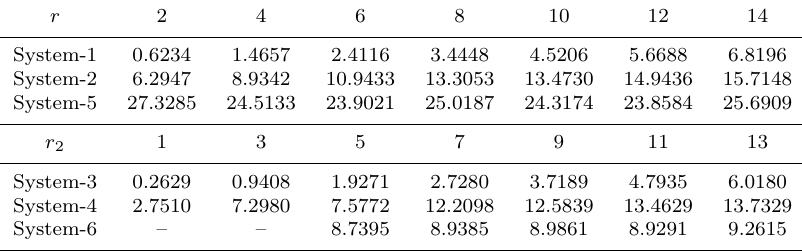
Table 4. Computational time (s) of obtaining reduced systems in Example